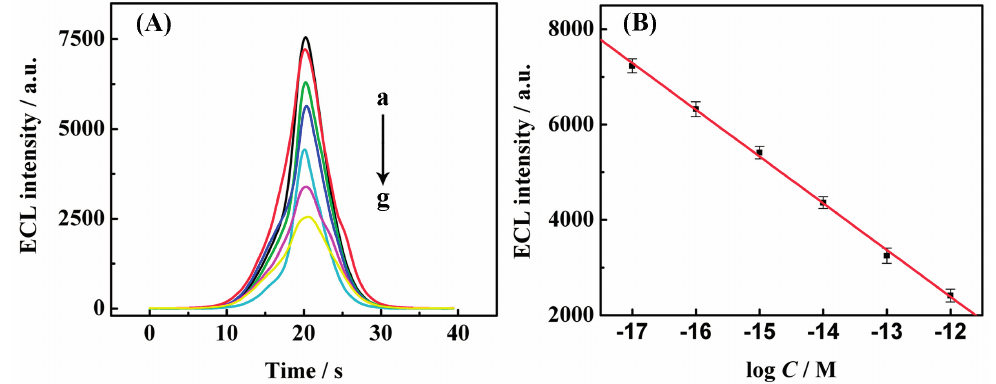
Figure 5. Sensitivity of modified electrodes. ( A ) ECL responses of the sensors to different concentrations of target DNA: (a) 0 M; (b) 10.0 aM; (c) 100.0 aM; (d) 1.0 fM; (e) 10.0 fM; (f) 100.0 fM; (g) 1.0 pM; ( B ) The resulting calibration plot of log c vs. ECL intensity (y = − 9371.2 − 980.1 logC; C: concentration of target DNA(M), y: ECL intensity, R 2 = 0.99). ECL measurement conditions were performed as described in Figure 3B, and all experiments were repeated 3 times (error bars = SD, n =